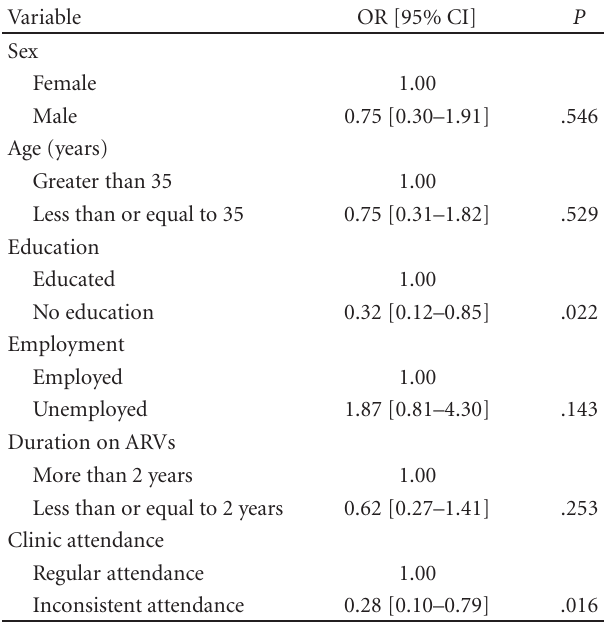
Table 4: Multivariate logistic regression analysis to determine predictors of optimal adherence.